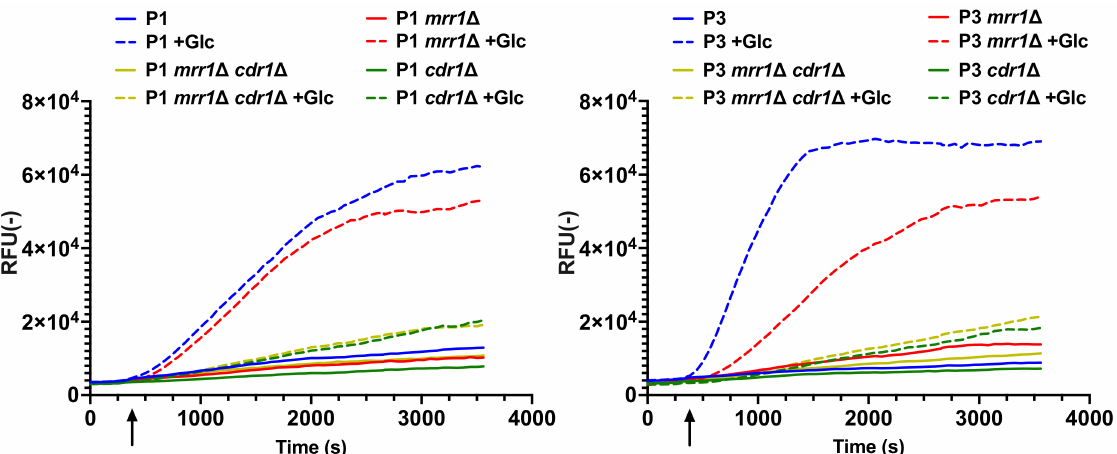
Figure 5. Rhodamine 6G efflux activities are dependent on the presence of CDR1 . Efflux activities were performed as described in Material and Methods. Means of duplicates are reported. Glucose was added 300 s after start of measurements (arrow). Maximal slopes were calculated with Graph Prism. Maximal slopes were derived from data points ranging between 740 and 1040 s and calculated by linear regression implemented in Graph Prism.